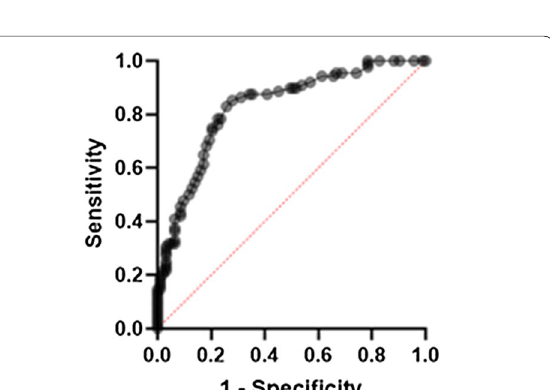
Fig. 2 Receiver operating characteristic curves generated with a generalized linear model of LBR for [ 68 Ga]Ga-PSMA PET. With the generalized linear model estimate, AUC for [ 68 Ga]Ga-PSMA PET